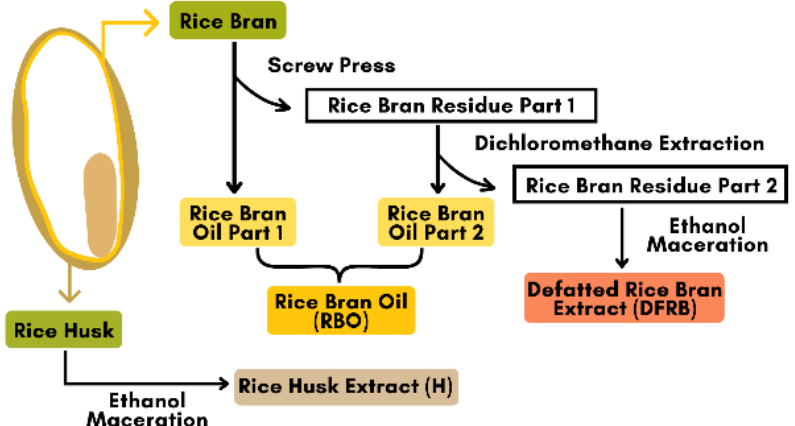
Figure 4. Scheme of rice by-products extraction from Oryza sativa L. cv. Bue Bang 3 CMU (BB3CMU) and Bue Bang 4 CMU (BB4CMU).